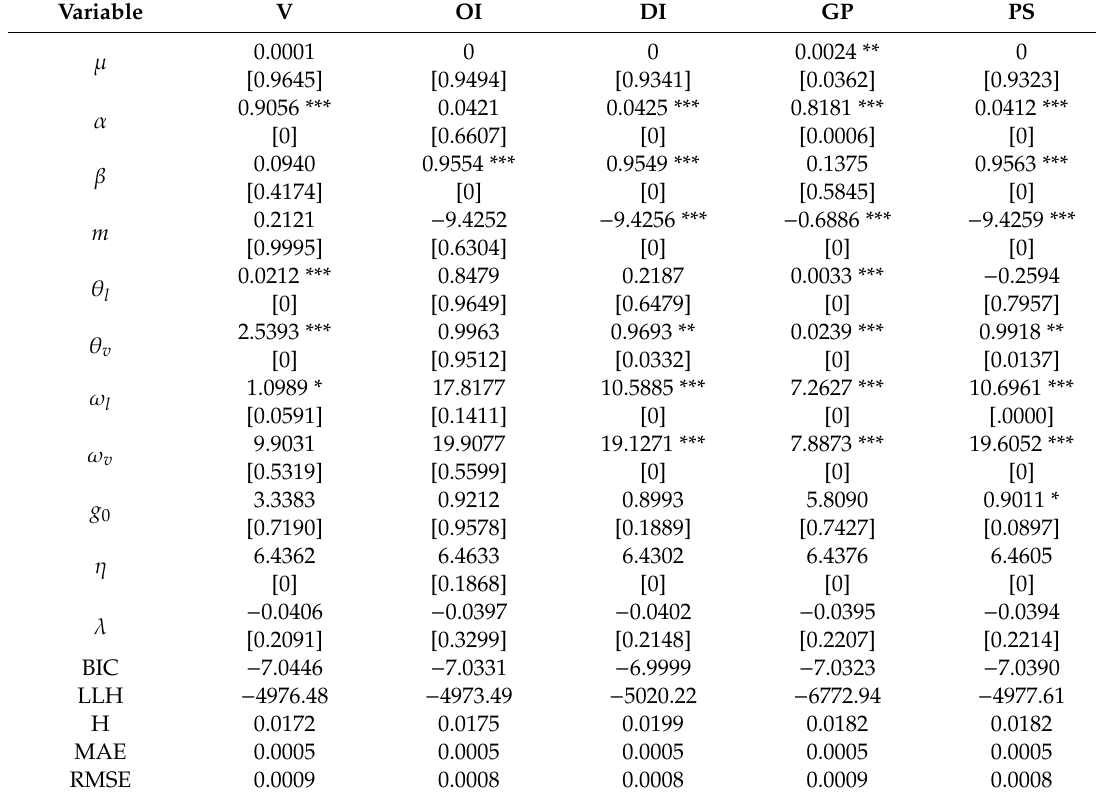
Table 9. Estimation results of associative model of level and fluctuation e ff ect in high-frequency factors. Variable